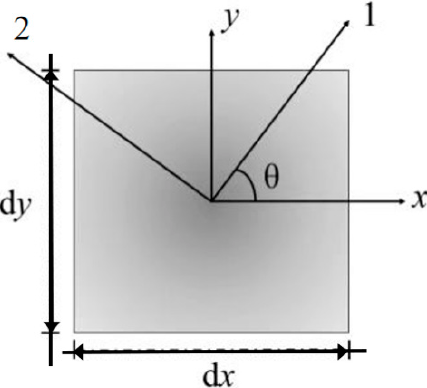
Figure 2. The principal axis directions of an element body in orthotropic material.